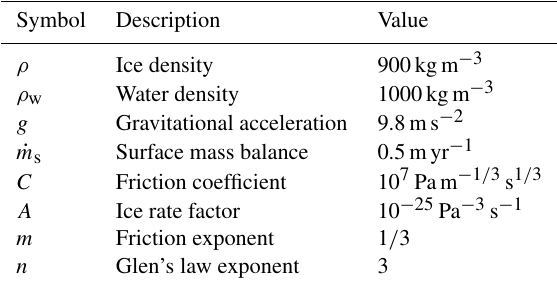
Table 3. Constants used in the MISMIP3D